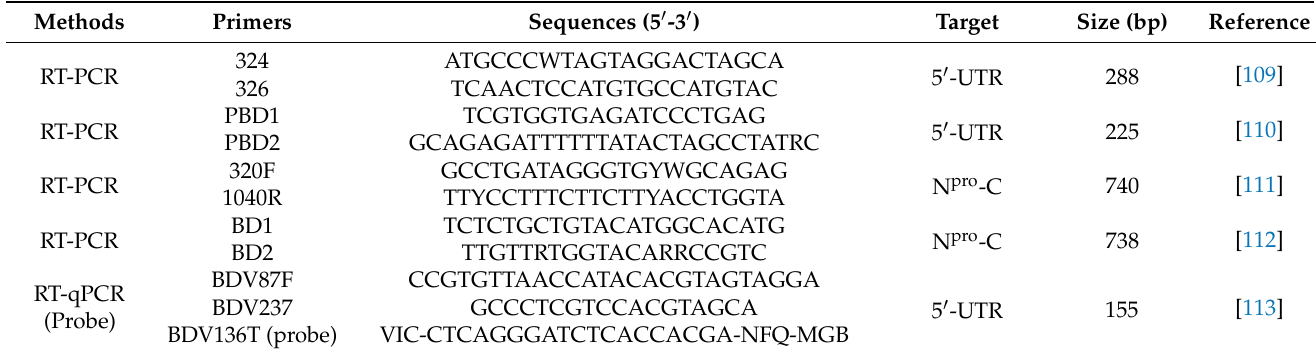
Table 4. Reported primers that can be used for BDV